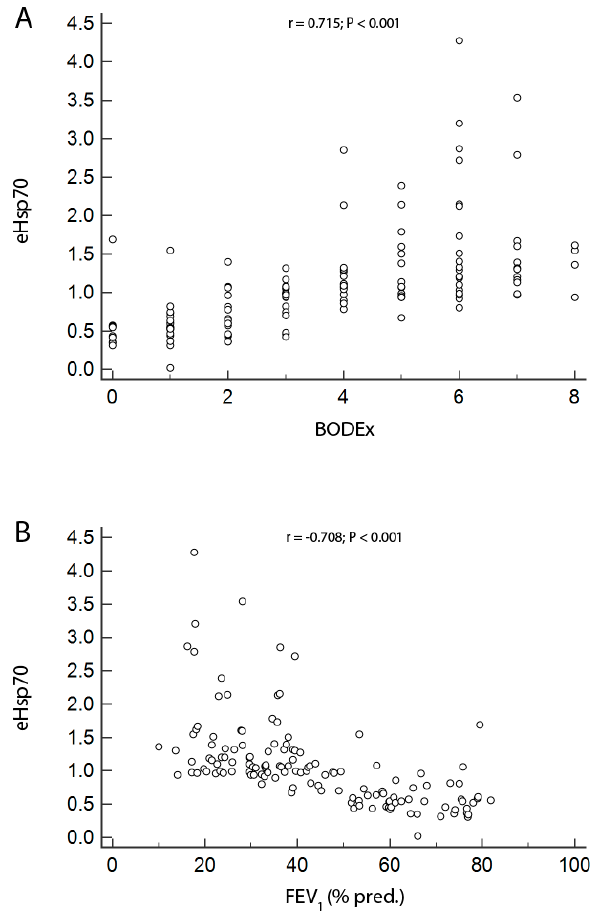
Figure 4. Association of eHsp70 with BODEx ( A ) and FEV 1 (% pred.) ( B ). r-Spearman’s correlation coefficient; BODEx—BMI, airflow obstruction, dyspnea, previous exacerbations; FEV 1 —forced expiratory volume in one second. Table 2. Spearman Rank Order analysis was performed between eHsp70 and COPD multicomponent indices as well as lung function parameters.